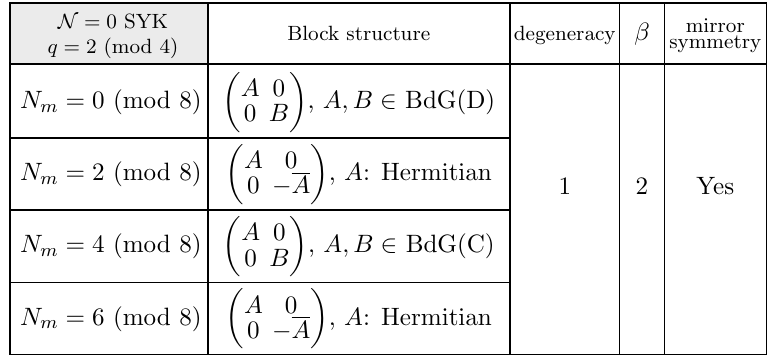
Table 3 . Symmetry classi(cid:12)cation of H in the Majorana SYK model (no SUSY) for q = 2 (mod 4). For the block structure of each class we refer to table